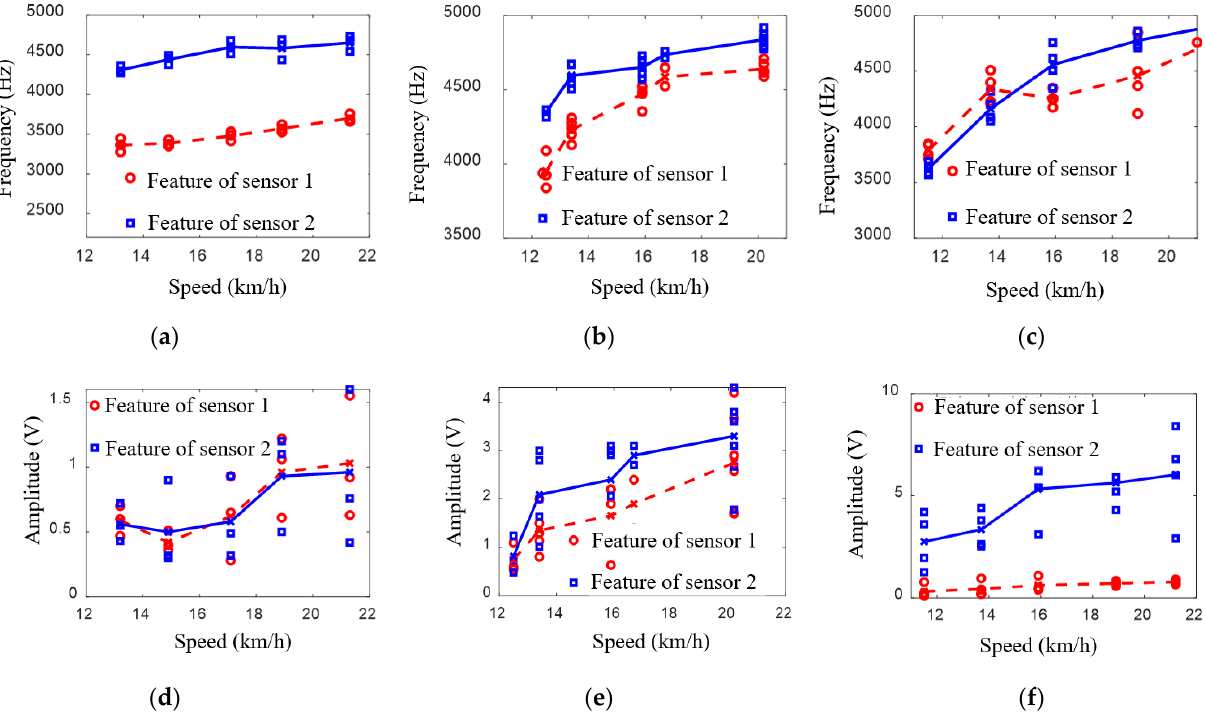
Figure 12. Frequency and amplitude features from different damage: ( a , d ) damage 2.5cm × 2cm; ( b , e ), damage 3cm × 1.5cm; ( c , f ) damage 1cm × 1cm.